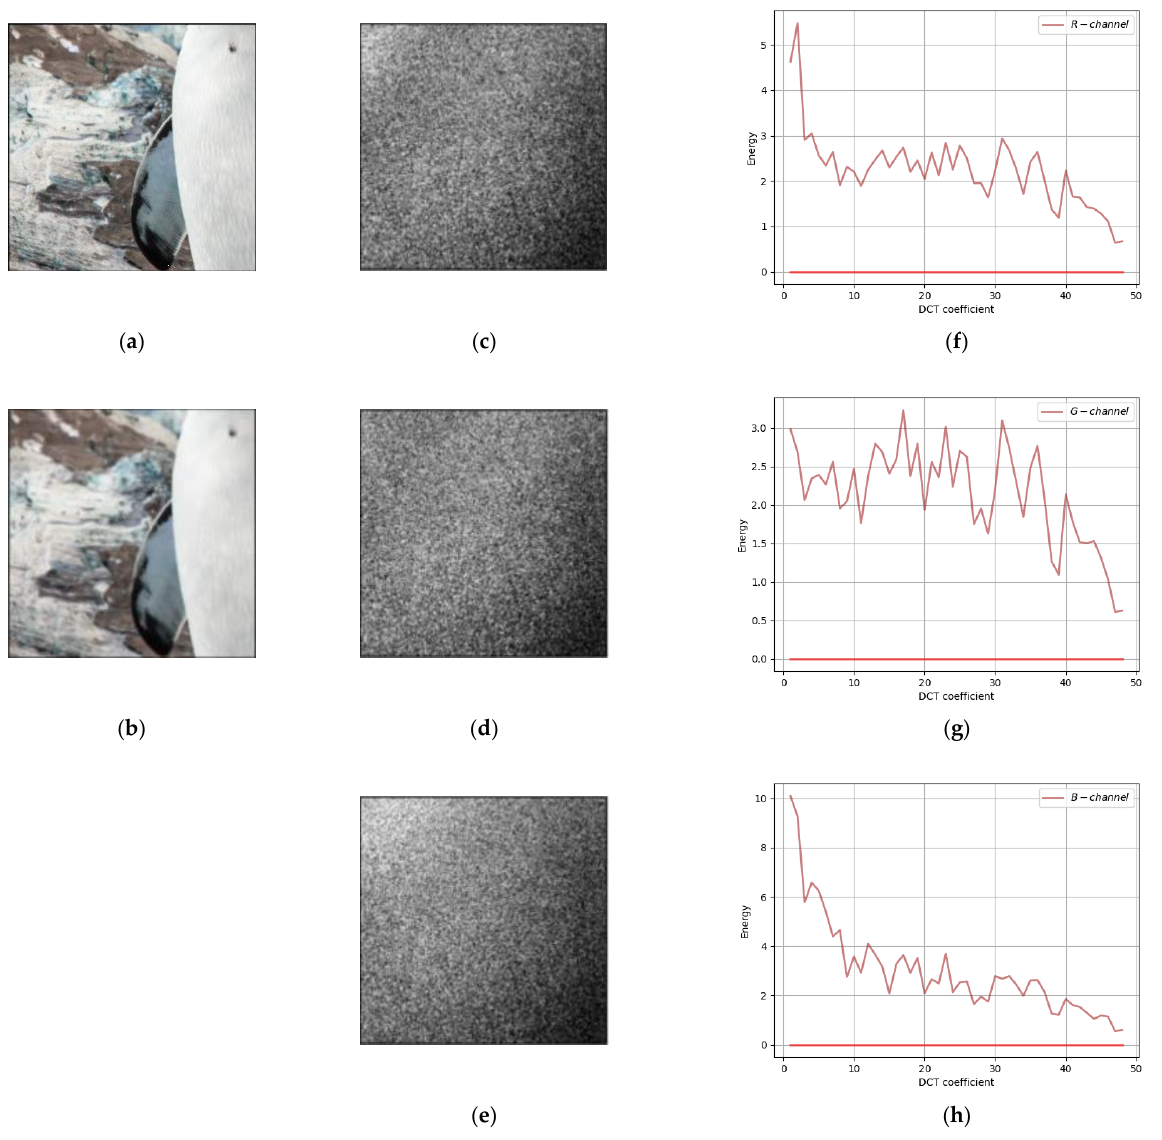
Figure 8. A frequency-domain residual analysis of F5. ( a ) Cover Image; ( b ) Steganographic Image; ( c ) R-channel DCT Domain Residual; ( d ) G-channel DCT Domain Residual; ( e ) B-channel DCT Domain Residual; ( f ) R-channel DCT residual curves; ( g ) G-channel DCT residual curves; ( h ) B-channel DCT residual curves.